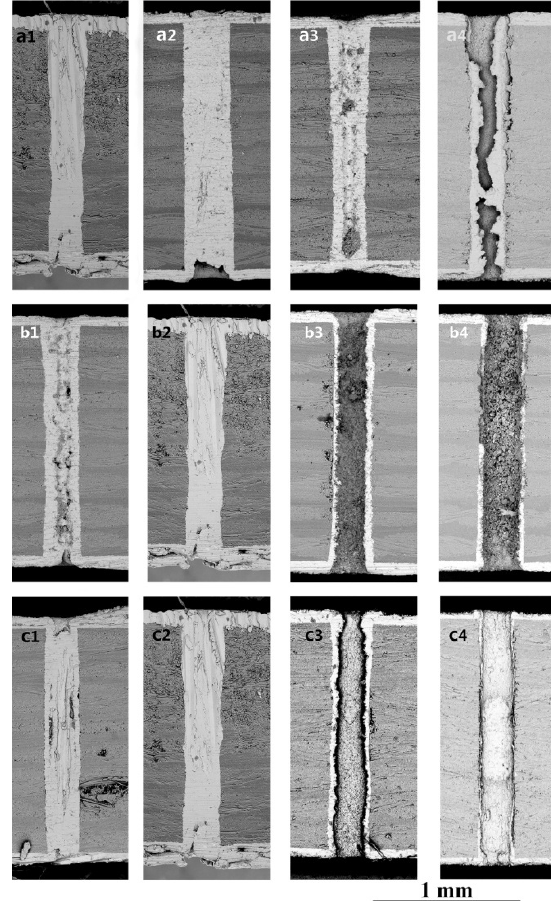
Figure 5. Cross-sectional observations of the filled PTH by PPR plating. ( a1 – a4 ) is reverse pulse frequency (HZ). ( b1 – b4 ) is reverse pulse duty cycle. ( c1 – c4 ) is reverse pulse current density (A/dm 2 ).